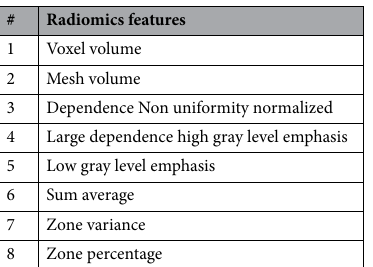
Table 2. Radiomics features after dimension reduction.